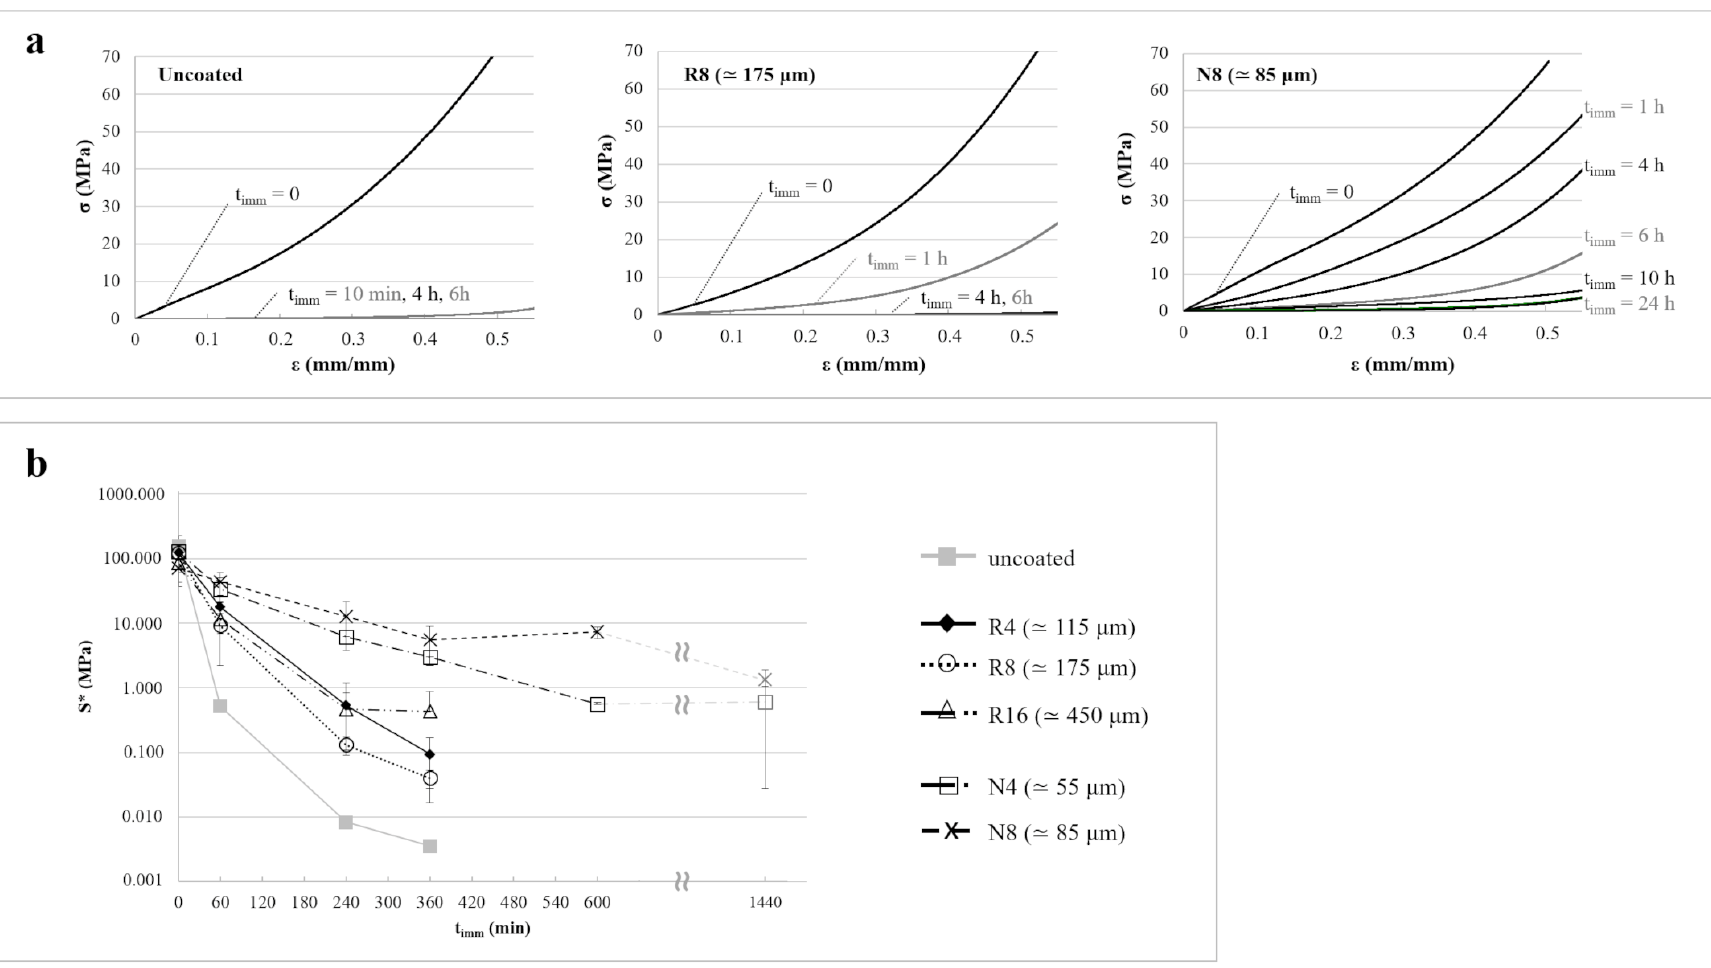
Figure 11. ( a ) Normalized load versus normalized displacement curves relevant to uncoated, R8, and N8 specimens tested under compressive conditions after different immersion times and ( b ) profiles of S* as a function of immersion time.